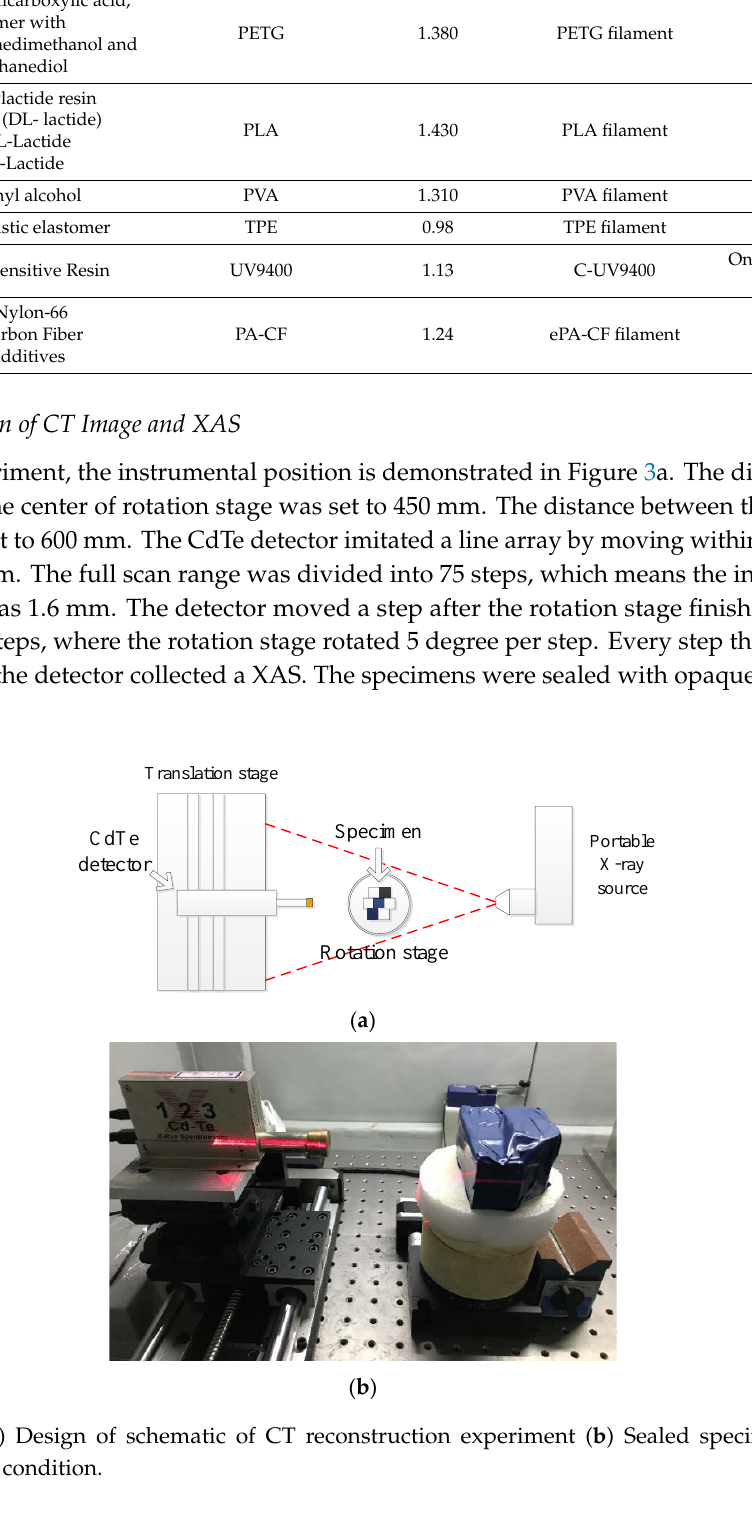
Table 1. Ingredients, abbreviations, density, and other information of 3D printing polymer.